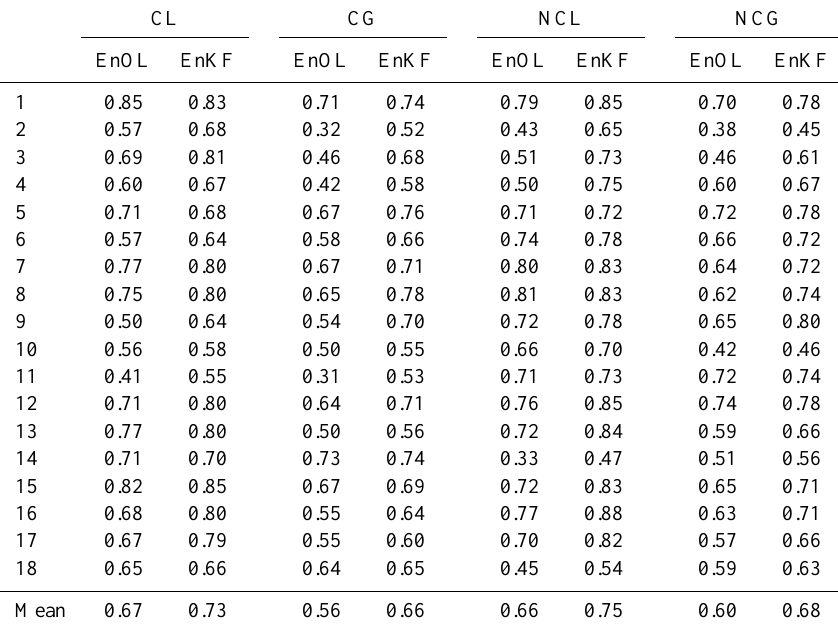
Table 4. Correlation coefficient computed between monthly mean estimated GW variation and monthly mean in situ variation. Names of the stations (first column) are provided in Appendix A.